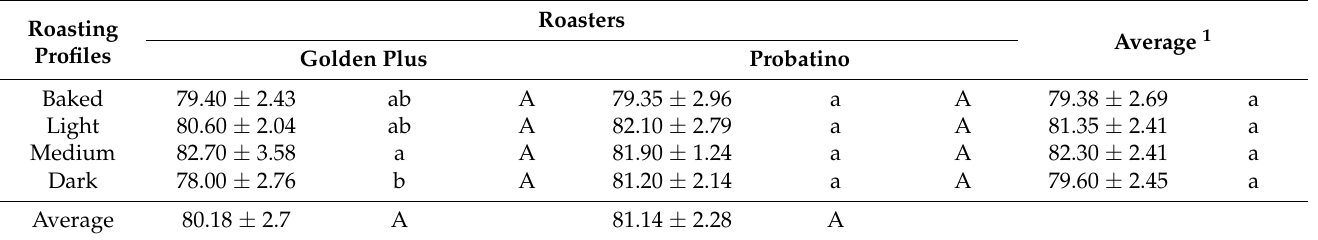
Table 3. Final sensory note of samples of coffee roasted in different roasting profiles (baked, light, medium, and dark) using two roasters.